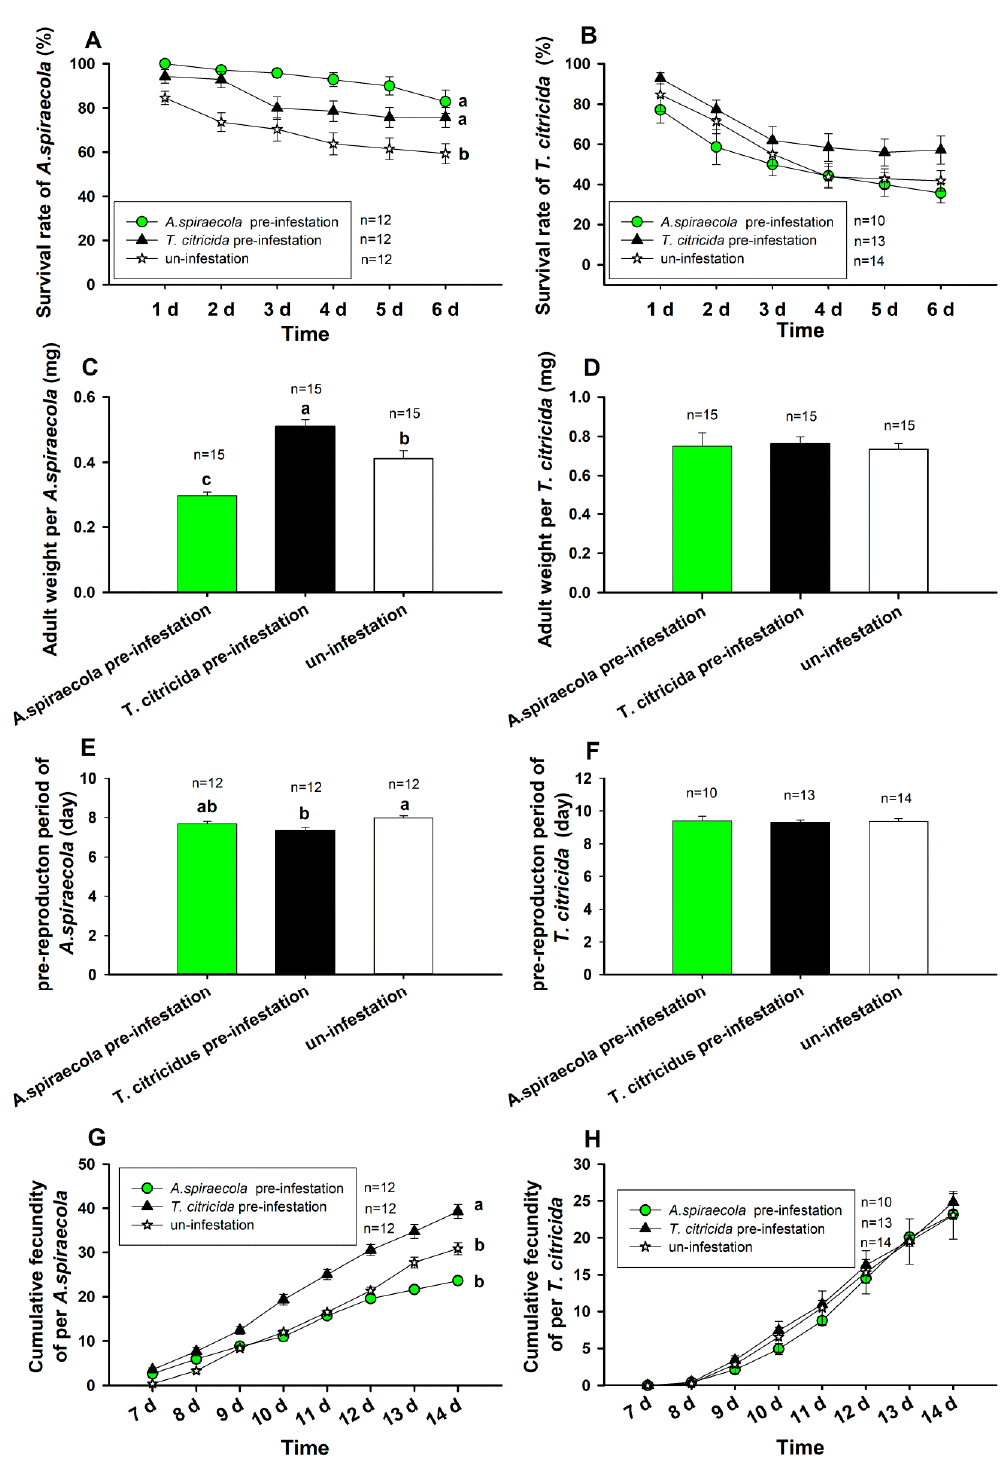
Figure 1. The life-history parameters of A. spiraecola and T. citricida feeding on sweet orange pre-infested by conspecific, heterospecific and without pre-infestation (control). The survival rate of A. spiraecola ( A ) and T. citricida ( B ), adult weight of A. spiraecola ( C ) and T. citricida ( D ), pre-reproductive period of A. spiraecola ( E ) and T. citricida ( F ), cumulative fecundity of A. spiraecola ( G ) and T. citricida ( H ) are represent the mean ± SEM. The numbers of replication are noted after treatment legends or above the bars. Di ff erent letters represent significant di ff erence (Tukey’s HSD test, p < 0.05). Bars or lines without letters indicate there is no significant di ff erence between treatments.